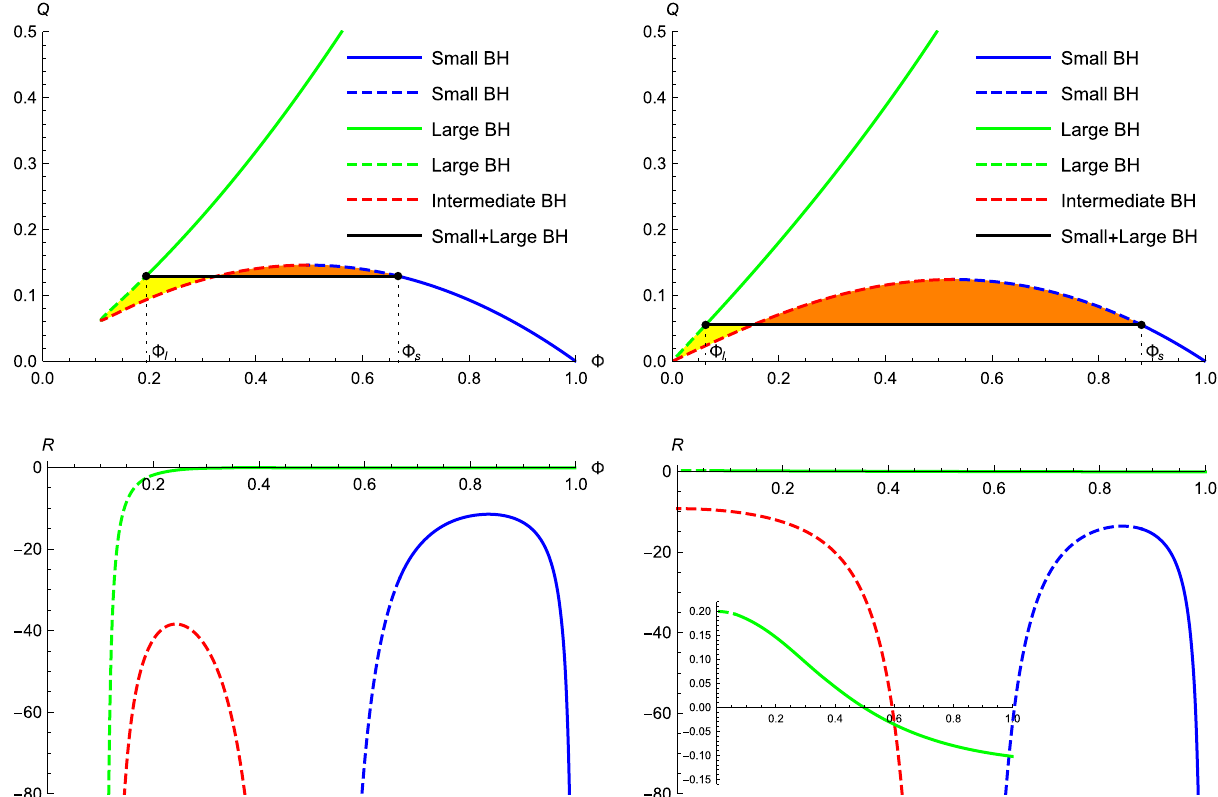
Fig. 4 The charge Q and the Ruppeiner invariant R as functions of the potential (cid:2) for a RN-AdS black hole with a temperature T > T c , which possesses three solutions for some range of (cid:2) . The (cid:2) - Q diagrams bear resemblance to that of the Van der Waals fluid. The coexisting lines of Large BH and Small BH are represented by the black lines, and (cid:2) l /(cid:2) s denotes the potential of the saturated Small/Large BH. The blue/green dashed lines represent metastable overcharged Small BH/undercharged